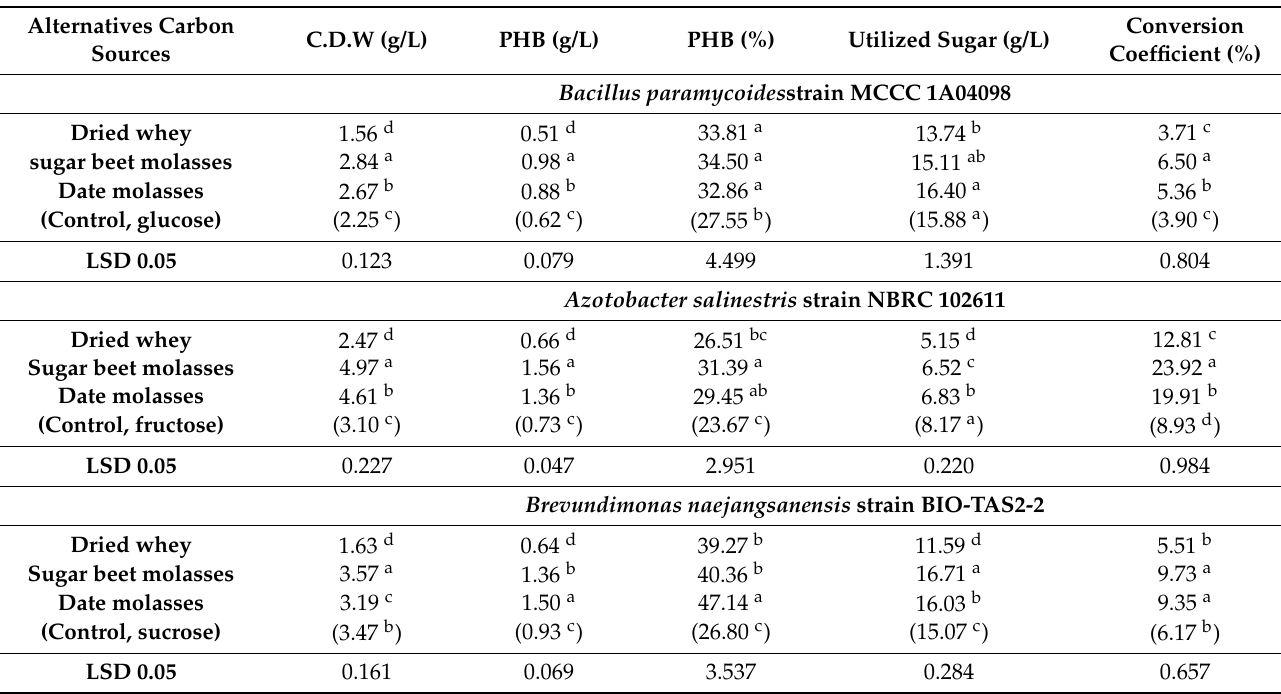
Table 2. Effect of cheap alternatives carbon sources on PHB production by different strains of Bacillus paramycoides , Azotobacter salinestris and Brevundimonas naejangsanensis